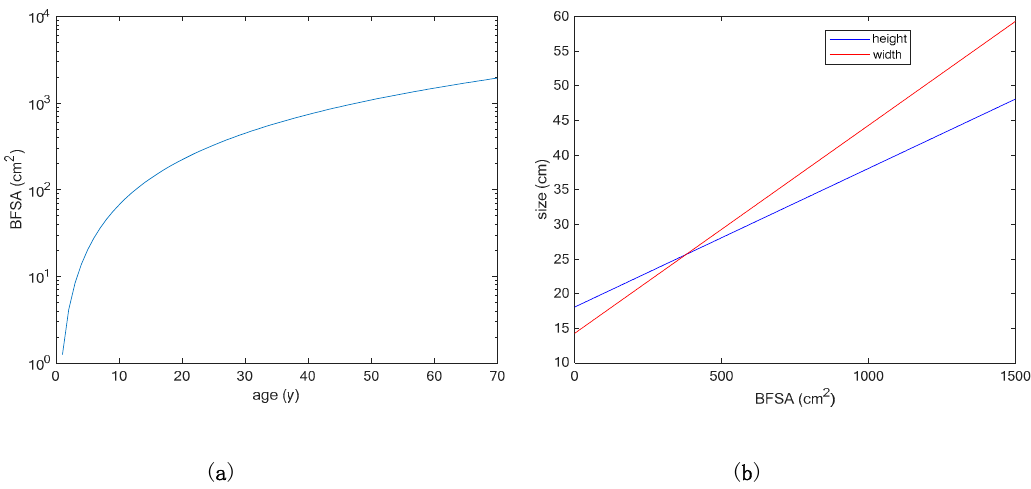
Figure 2. Model A [33]. ( a ) Estimated behavior of the BFSA (branch fan surface area) versus age in Eunicella verrucosa ; ( b ) Linear correlation between the BFSA and height (blue) or width (red) of the colonies.